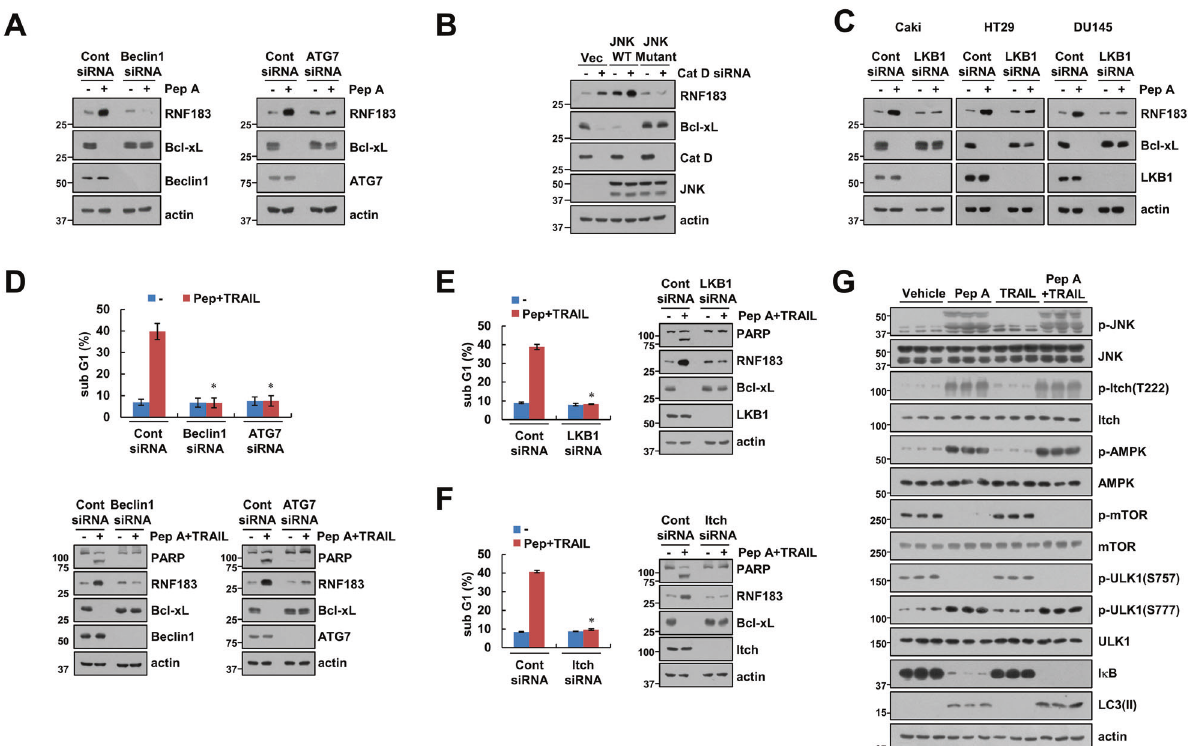
Fig. 6 Autophagy-dependent degradation of I κ B increases RNF183 expression. A Caki cells were transiently transfected with Cont siRNA, Beclin1 siRNA, and ATG7 siRNA; they were further treated with 2 μ M Pep A for 24 h. B Caki cells were transiently co-transfected with Cont siRNA or Cat D siRNA and JNK WT or JNK mutant for 24 h. C Cancer cells (Caki, HT29, and DU145) cells were transiently transfected with Cont siRNA or LKB1 siRNA, and they were then treated with 2 μ M Pep A for 24 h. D – F Caki cells were transiently transfected with Cont siRNA, Beclin1 siRNA ( D ), ATG7 siRNA ( D ), LKB1 siRNA ( E ), and Itch siRNA ( F ), and they were further treated with 2 μ M Pep A and 50 ng/mL TRAIL for 24 h. G Mice were treated with 5 mg/kg Pep A, 3 mg/kg GST-TRAIL, a combination of Pep A and GST-TRAIL, or vehicle for 16 days. Protein expression was measured via western blotting ( A – G ). Apoptosis was measured via fl ow cytometry ( D – F ). Values in the graphs ( D – F ) represent mean ± SD of three independent experiments. * p < 0.01 compared to Pep A plus TRAIL in Cont